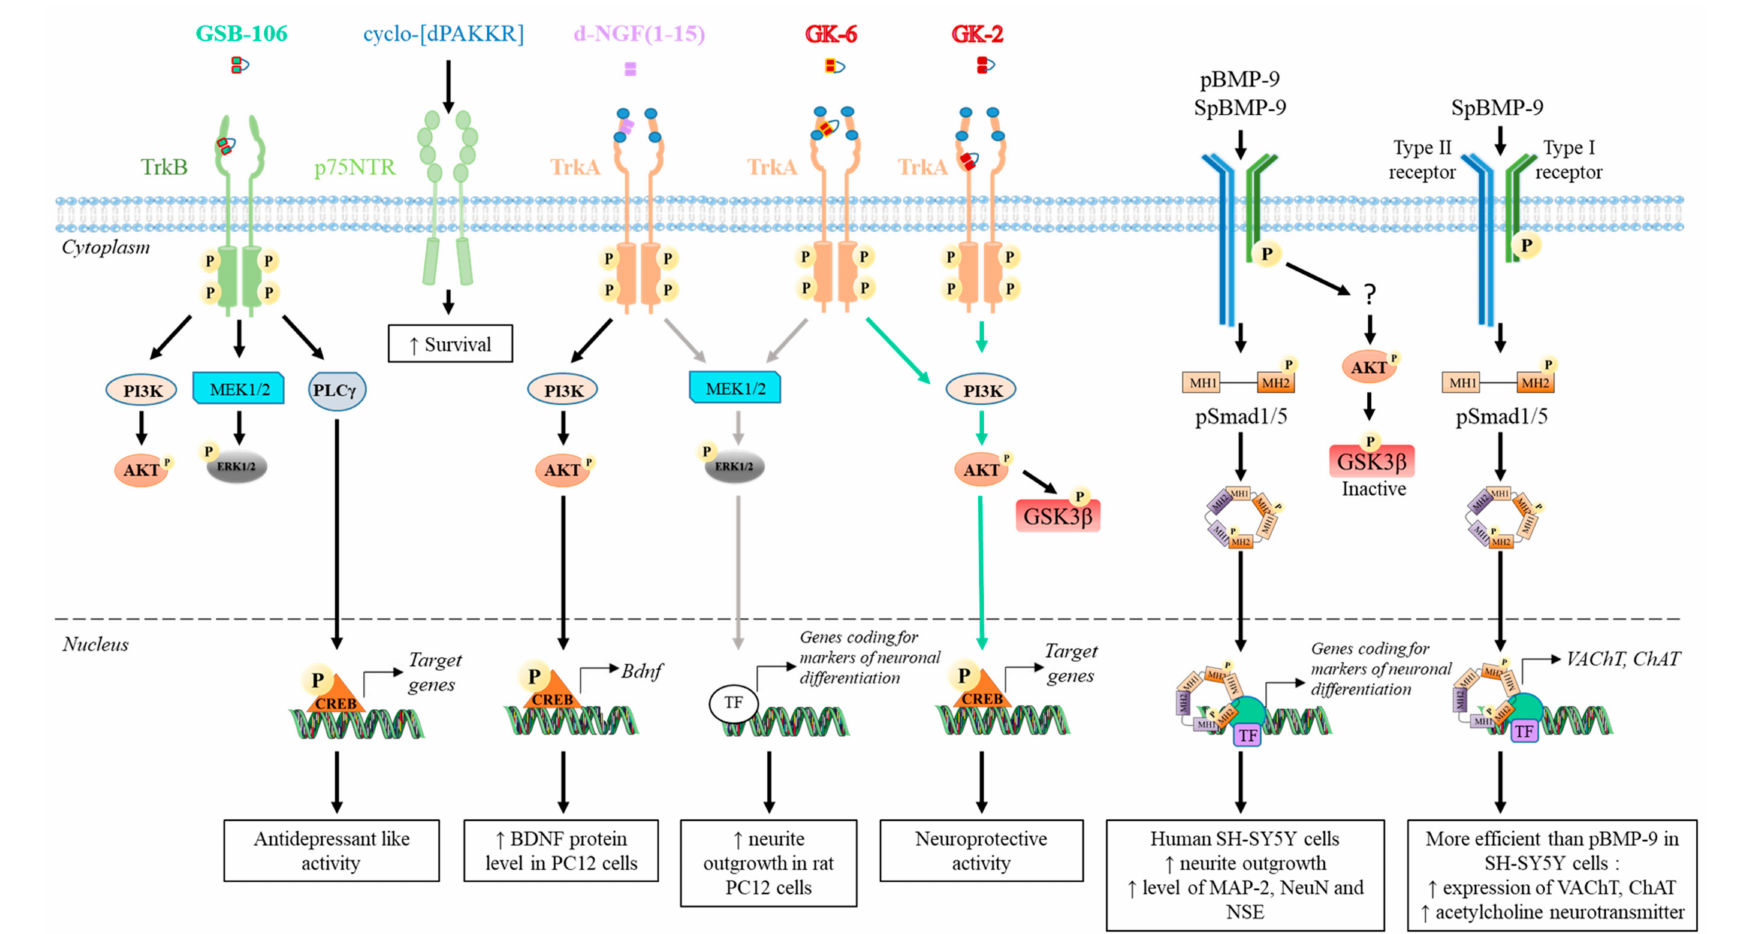
Figure 4. Signaling pathways activated by peptides derived from growth factors and their effect in vitro and/or in vivo [232,239,243–245]. The figure was created using Servier Medical Art (https://smart.servier.com; 30 April